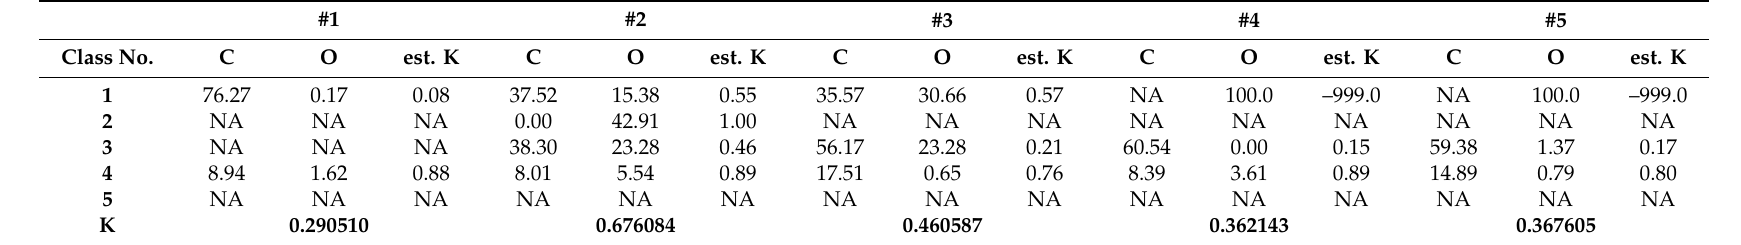
Table 7. The accuracy assessment of the Artificial Neural Network for the Osijek study